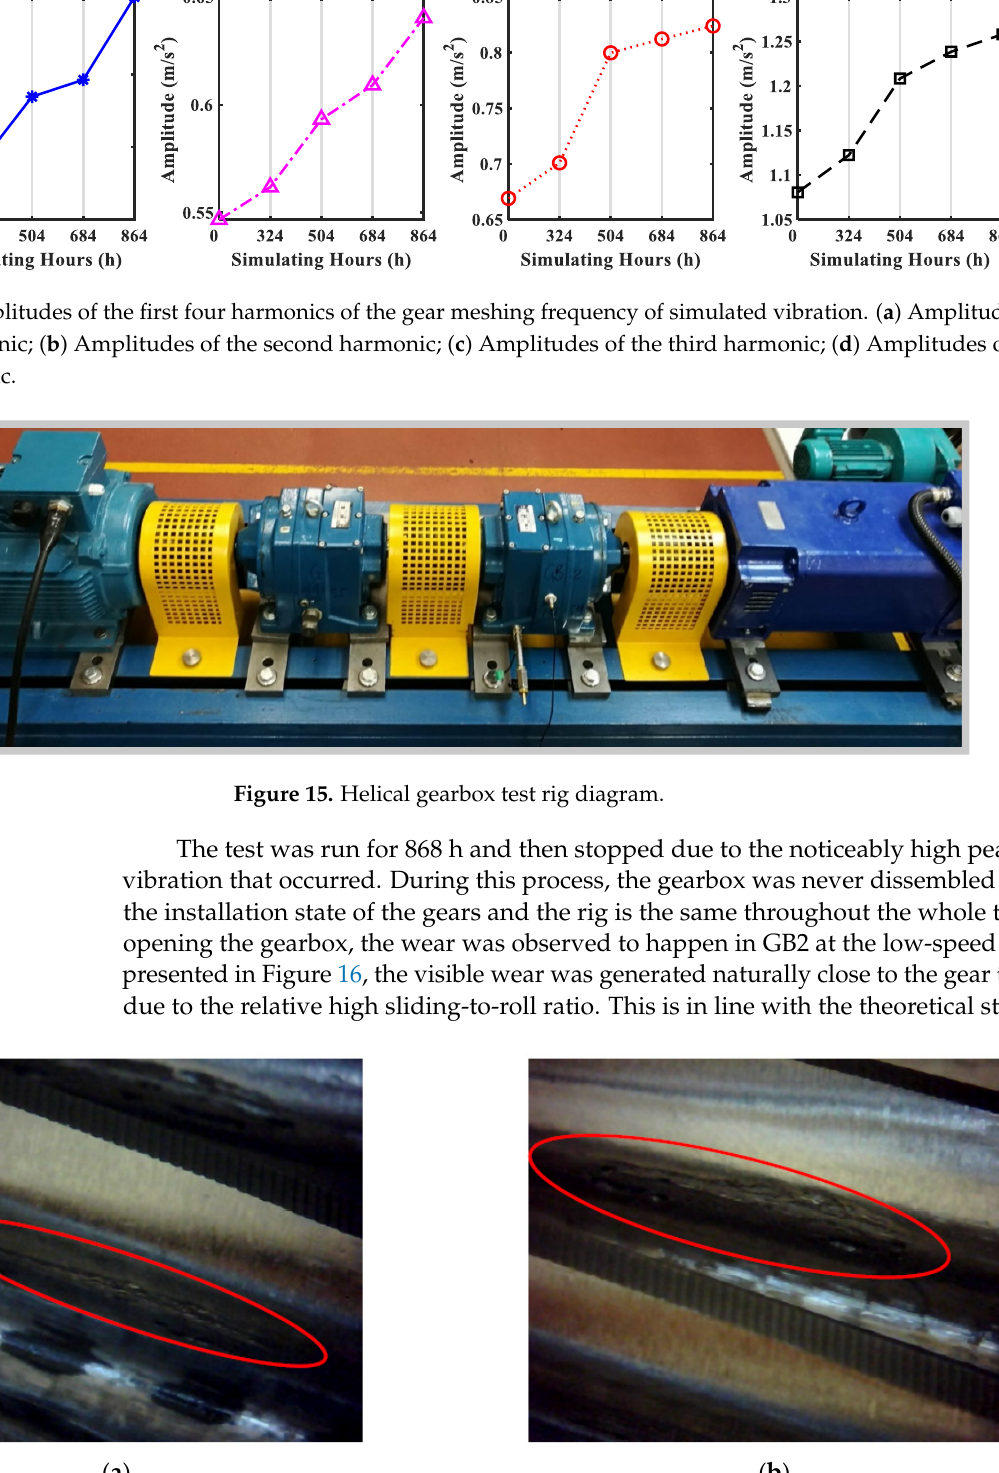
Figure 15. Helical gearbox test rig diagram.